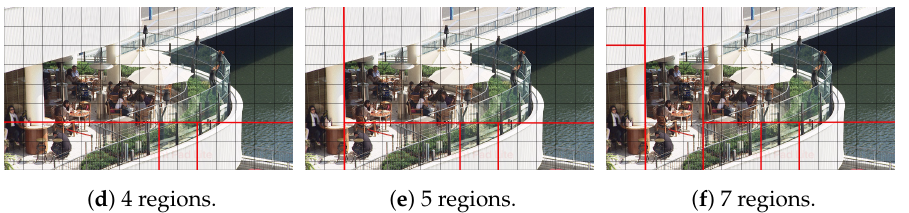
Figure 10. BQTerrace video sequence: ( a – c ) Serial Region Growing, ( d – f ) Concurrent Region